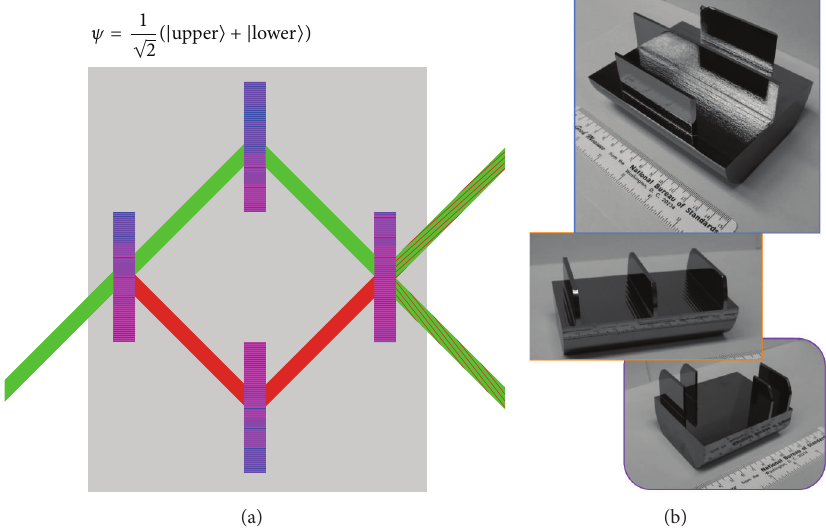
Figure 2: (a) Schematic diagram of the neutron paths in a perfect single crystal neutron interferometer. The neutron passing through the interferometer is coherently split into two paths (upper and lower) by the first interferometer blade, redirected by the middle blades (these blades represent mirrors of the light Mach-Zehnder interferometer and are recombined to observe interference effects by the last blade). The neutron’s wave function can be described as superposition of the paths inside the interferometer. (b) Pictures of NIST interferometers with high contrast ( >